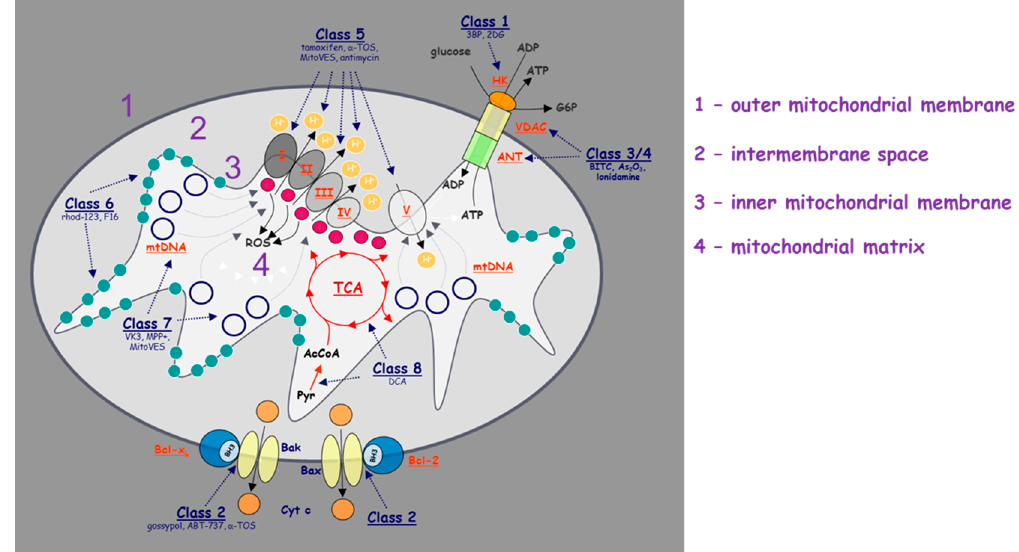
Figure 3. Schematic illustration of the molecular targets of individual classes of mitocans. The classes of mitocans comprise the following, as enumerated from the outside of the mitochondria towards the matrix. Class 1: hexokinase inhibitors; Class 2: BH3 mimetics and related agents that impair the function of the anti-apoptotic Bcl-2 family proteins; Class 3: thiol redox inhibitors; Class 4: agents targeting VDAC and ANT; Class 5: compounds targeting the mitochondrial electron transport chain; Class 6: hydrophobic cations targeting the MIM; Class 7: compounds that affect the TCA; and Class 8: agents that interfere with mtDNA. Class 9 (not shown) includes agents acting on mitochondria, whose molecular target has not been thus far described [10].